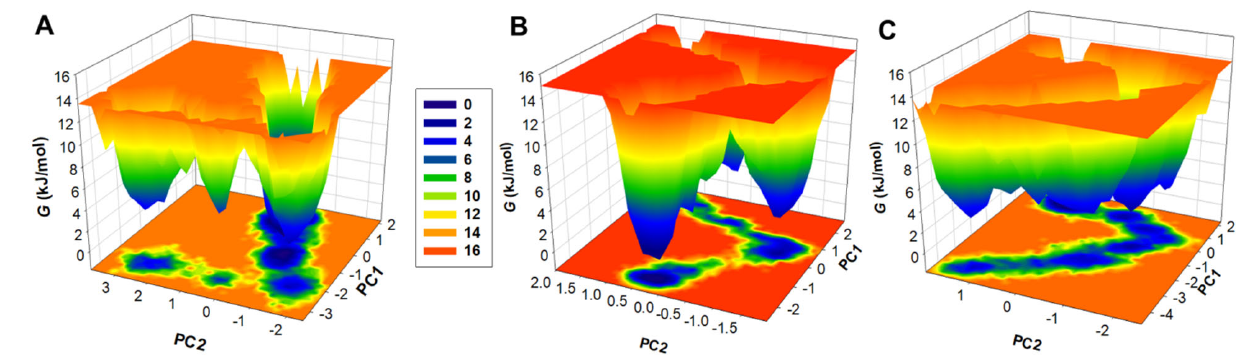
Figure 8. The free energy landscapes (FELs) of ( A ) AKT1, ( B ) AKT1 ‐ tuberosin complex, and ( C ) AKT1 ‐ villosol complex.